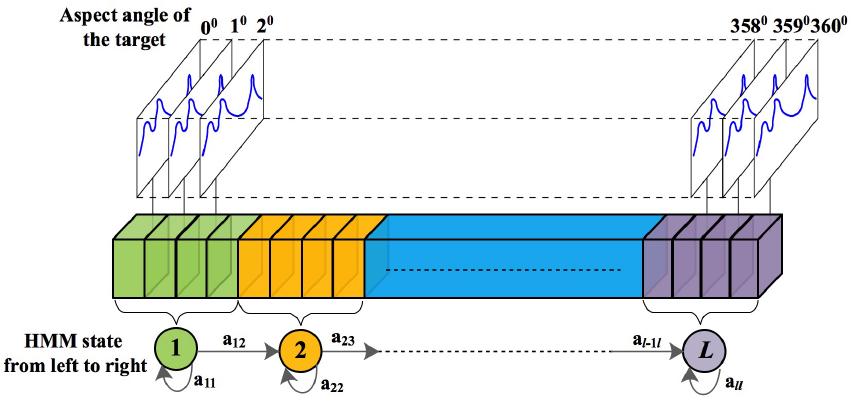
Figure 5. The basic process of HMM model